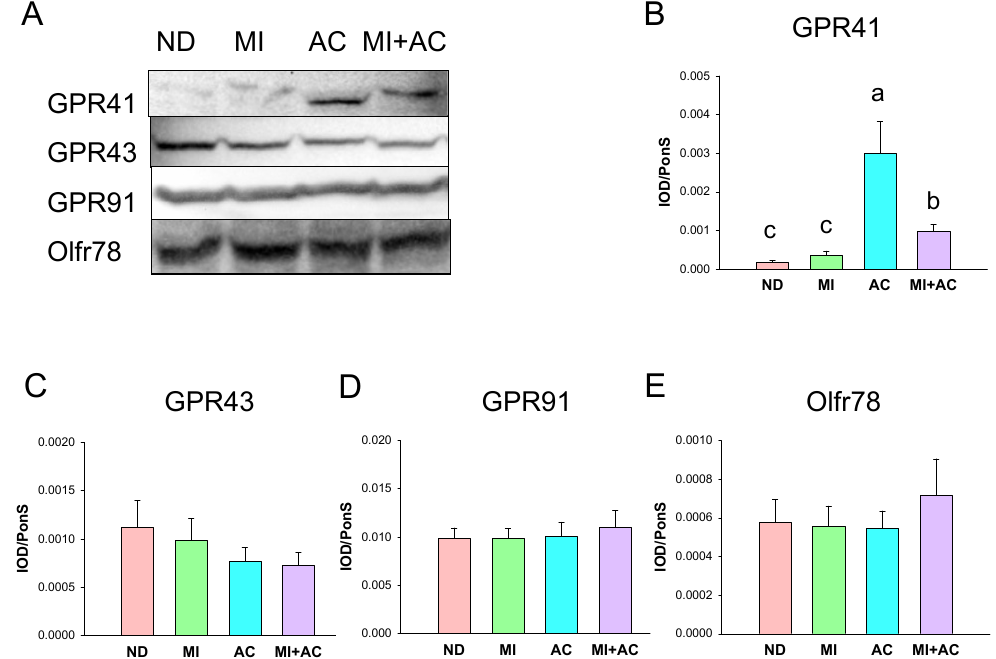
Figure 2. Representative Western blots and relative abundance of ( A ) short-chain fatty acid (SCFA) receptor, ( B ) G protein-coupled receptor 41 (GPR41), ( C ) GPR43, ( D ) GPR91, and ( E ) olfactory receptor 78 (Oflr78) in 12-week-old offspring kidneys ( n = 7–8/group). The letters a, b, and c above the bars denote significant differences between groups ( p < 0.05, one-way ANOVA). ND = rats received vehicle (control); MI = rats received minocycline; AC = rats received acetate; MI + AC = rats received minocycline and acetate